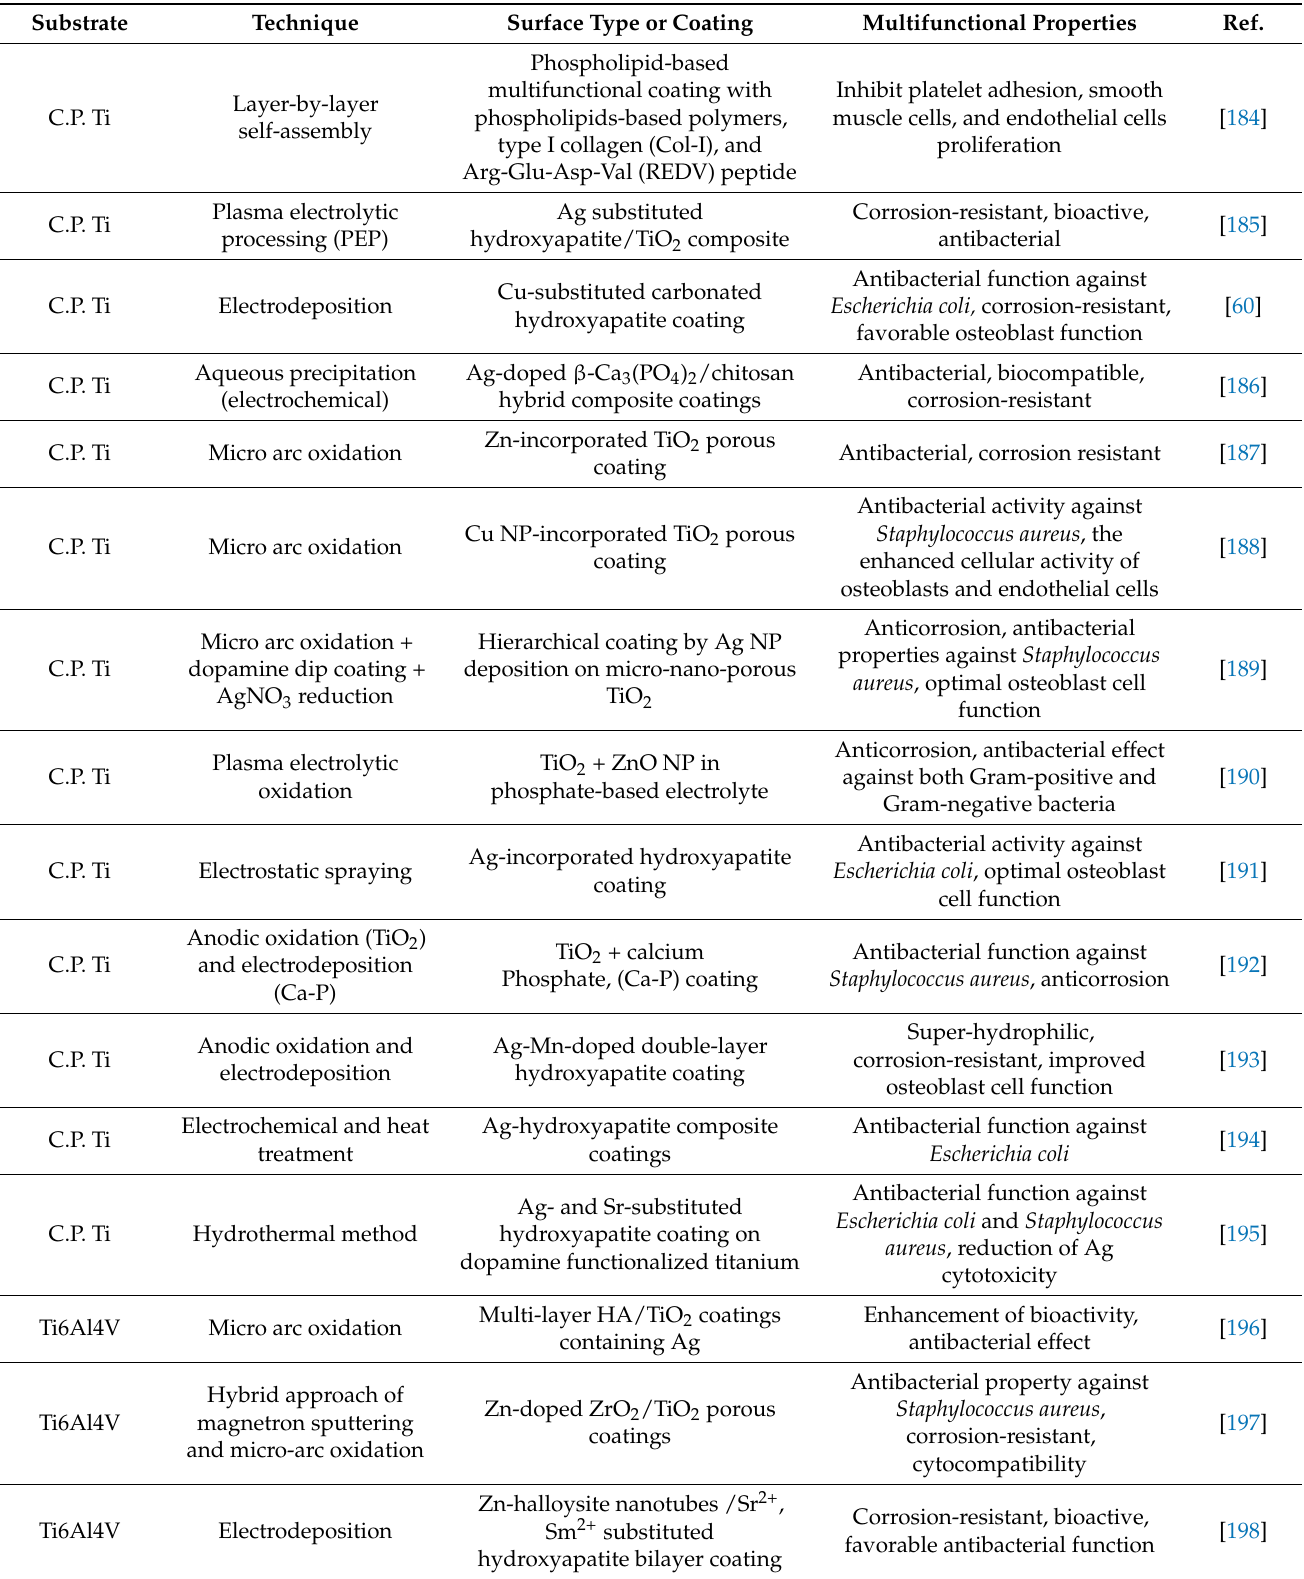
Table 1. The multifunctional properties in Ti and Ti6Al4V alloy, techniques, and surface types.